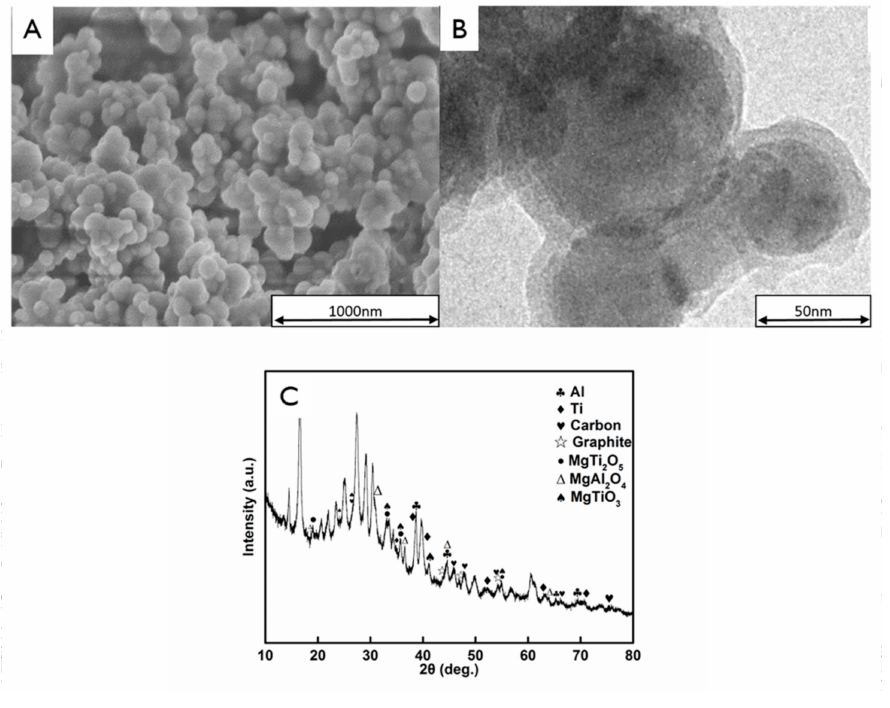
Figure 4. Analysis of the AlTi-MgO NPs coated with PDA, showing the: ( A ) SEM image; ( B ) TEM image; and ( C ) XRD pattern.